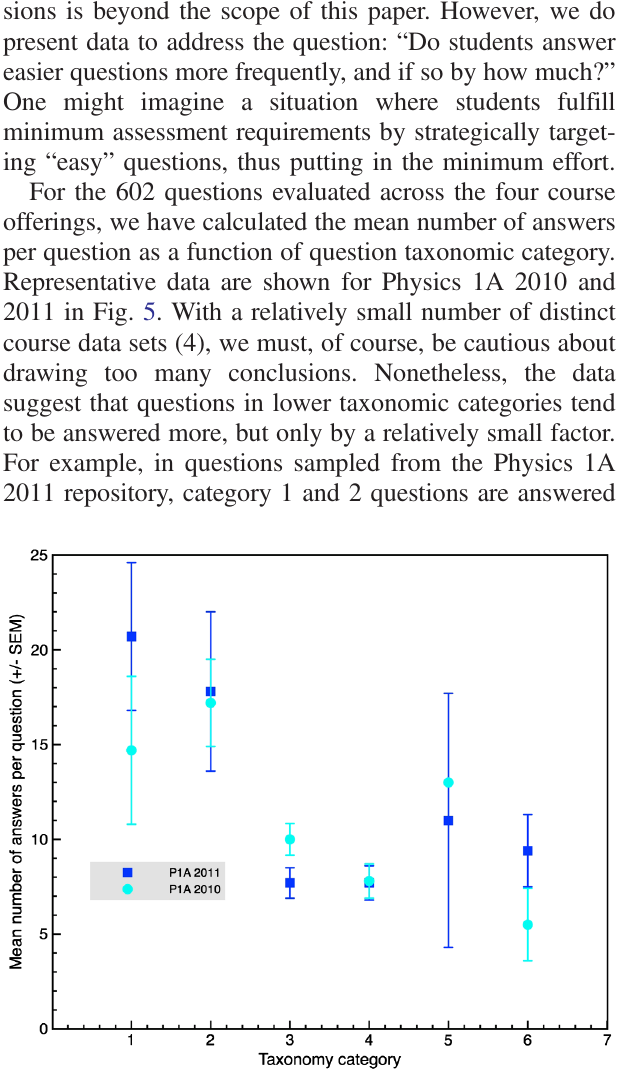
FIG. 5. Mean number of student responses per question as a function of question taxonomy, for Physics 1A course reposito- ries for the 2010 and 2011 cohorts. Error bars denote the standard error on the mean. Note that for P1A 2010, there was only one category 5 question in the